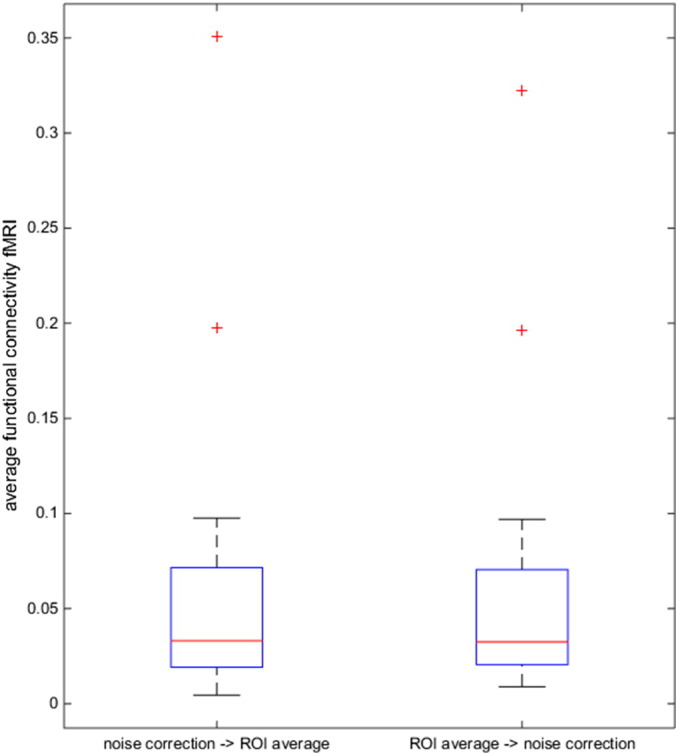
Estimated parameters (Taylor coefficients) for analysis level 1 using model b, linear approximation based on all MEG frequency bands using the AEC as functional connectivity metric for MEG. Note that the confidence intervals of the estimated Taylor coefficients for the two datasets almost completely overlap.